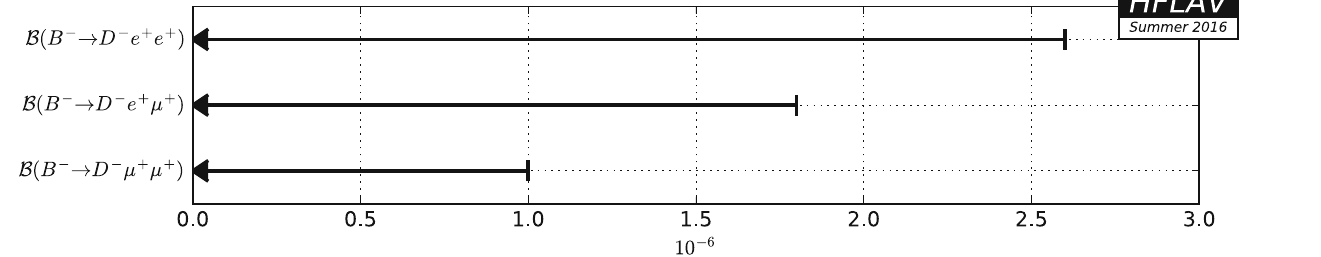
Fig. 119 Summary of the averages from Table